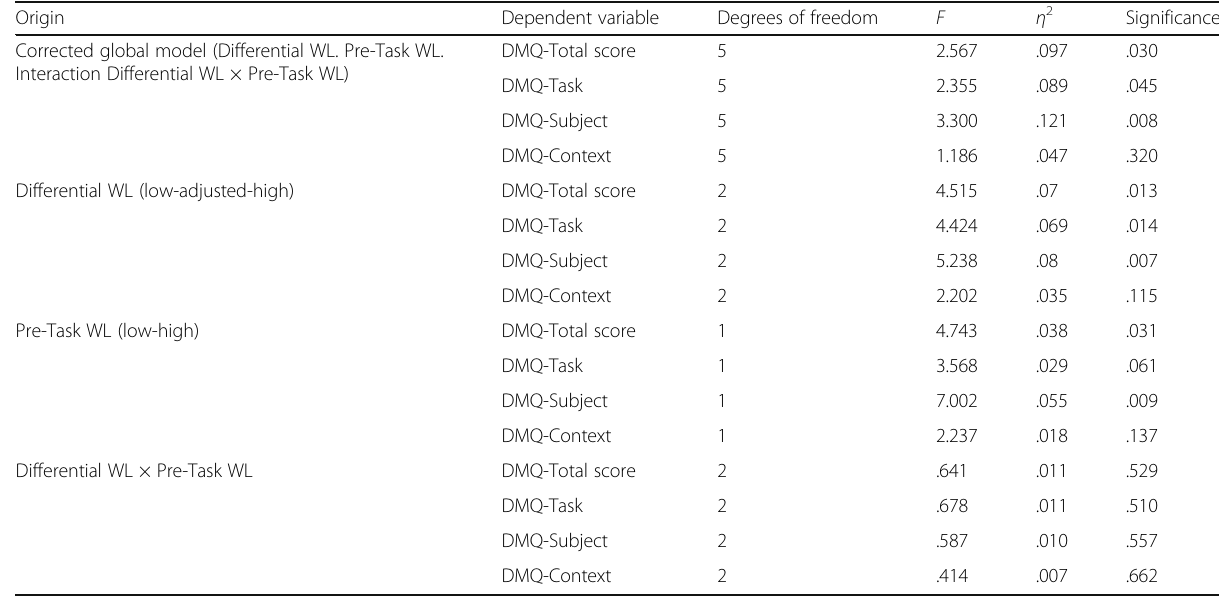
Table 5 MANOVA including DMQ scores, Differential Workload (Grouped), and Pre-Task Workload (Grouped). Inter-subject tests